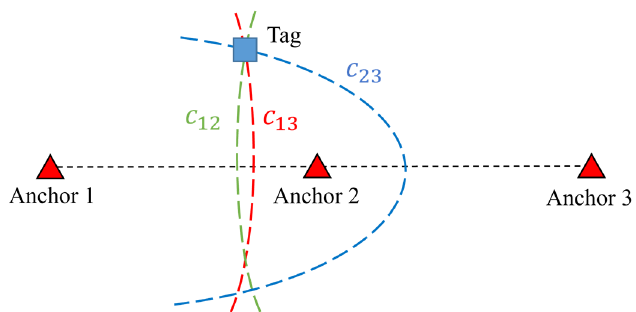
Figure 28. Hyperbolas in a 3 ‐ anchor 1D group.